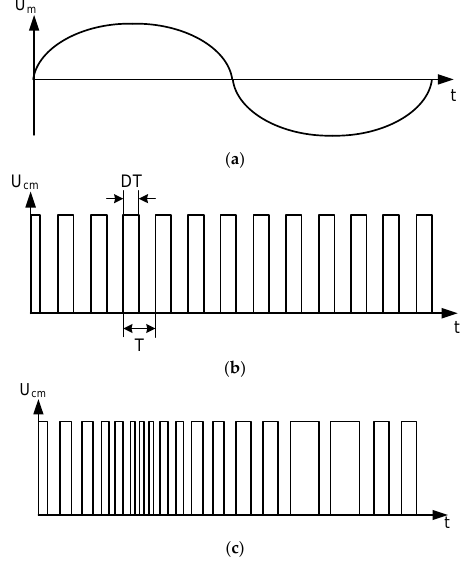
Figure 3. Sinusoidal modulation of FM rectangular waves: ( a ) Modulation Wave; ( b ) Carrier; and ( c ) PFM.